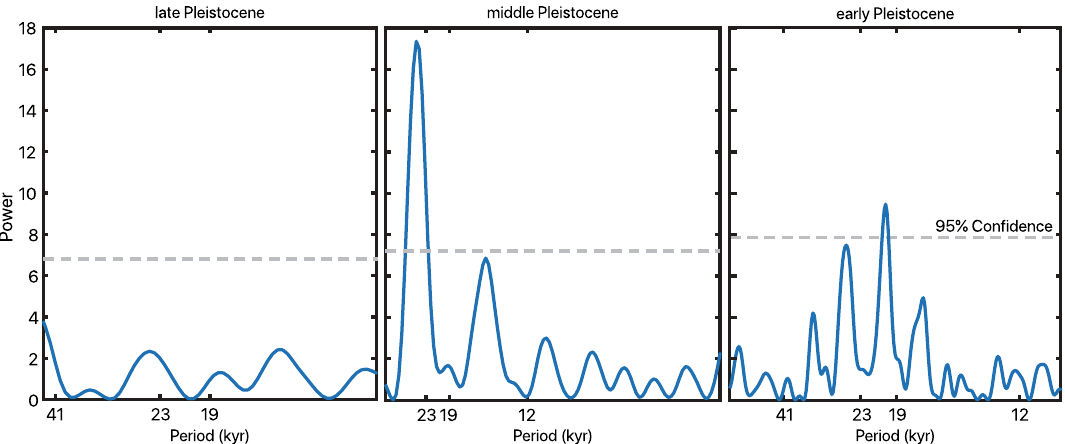
Figure 3. Lomb-Scargle spectral analyses for unevenly sampled data of δD precip from the early (1900–1500 ka), middle (250–130 ka), and late (130–0 ka) Pleistocene. Precession-band 19- and 23-kyr periodicities lie above the 95% confidence line (dashed grey) in the early and middle Pleistocene. Frequency distribution is plotted from ½× the Nyquist frequency as the high-frequency cutoff to 1/3 of the total length of interval as the low-frequency cutoff, thus the differing x-axes of the three windows depend on the resolution and length of the specific